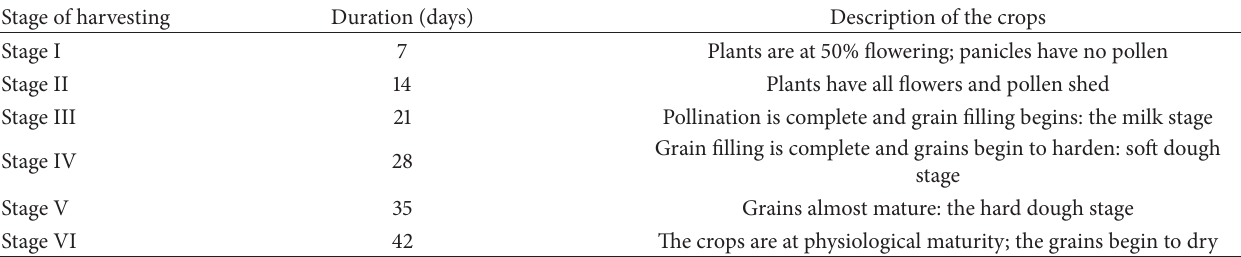
Table 1: Harvesting stage, duration after intrusion, and description of crop appearance.